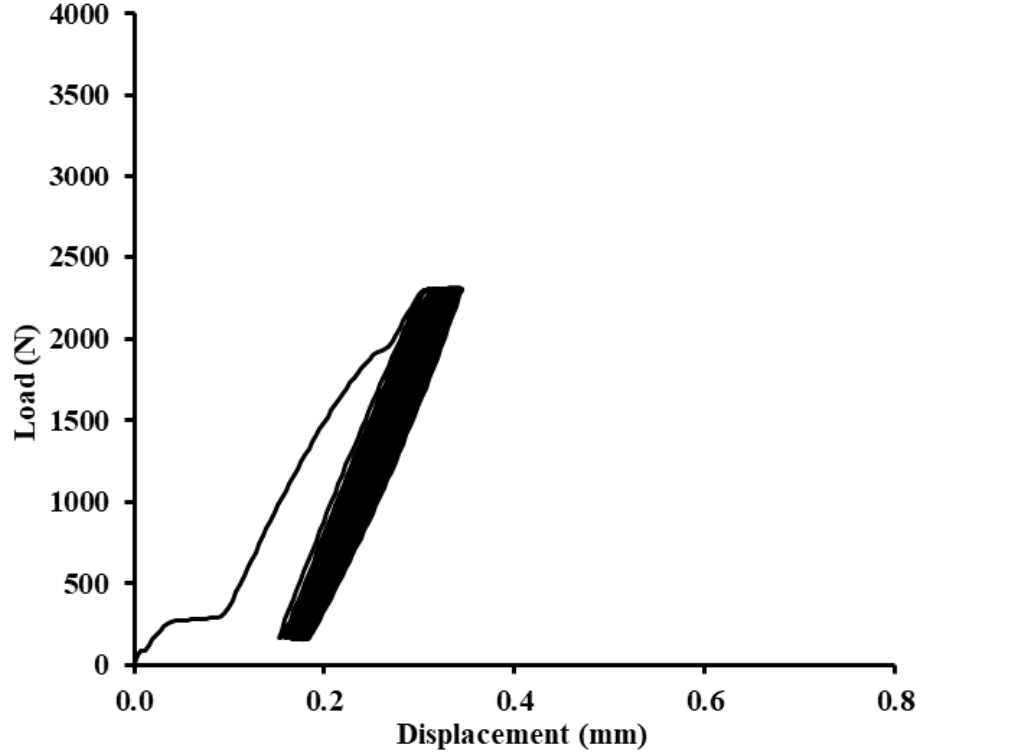
Figure 17. Quasi-static graph of adhesive bond ABFE2 with loading 5–70% (165–2307 N)—1000 cycles. Figure 18A shows the fracture surface inside of the adhesive layer, i.e., adhesive/cohesive failure type of the adhesive bond. The fracture surface of the adhesive bond was changed by adding the filler. The adhesive bonds without filler had an adhesive fracture surface. The adhesive bonds with the filler had an adhesively cohesion fracture surface from 80% (Figure 18A). Figure 18B,C present a good adhesive strength, i.e., a good interaction between matrix and eggshells microparticles. The surface of eggshell microparticles, which indicates porosity, is evident from Figure 18B,C. The porosity is used for good wettability of the matrix and filler. It leads to an adhesive surface enlargement (Figure. 18C). From Figure 18B,C, it is evident that the adhesive moistens the micropores